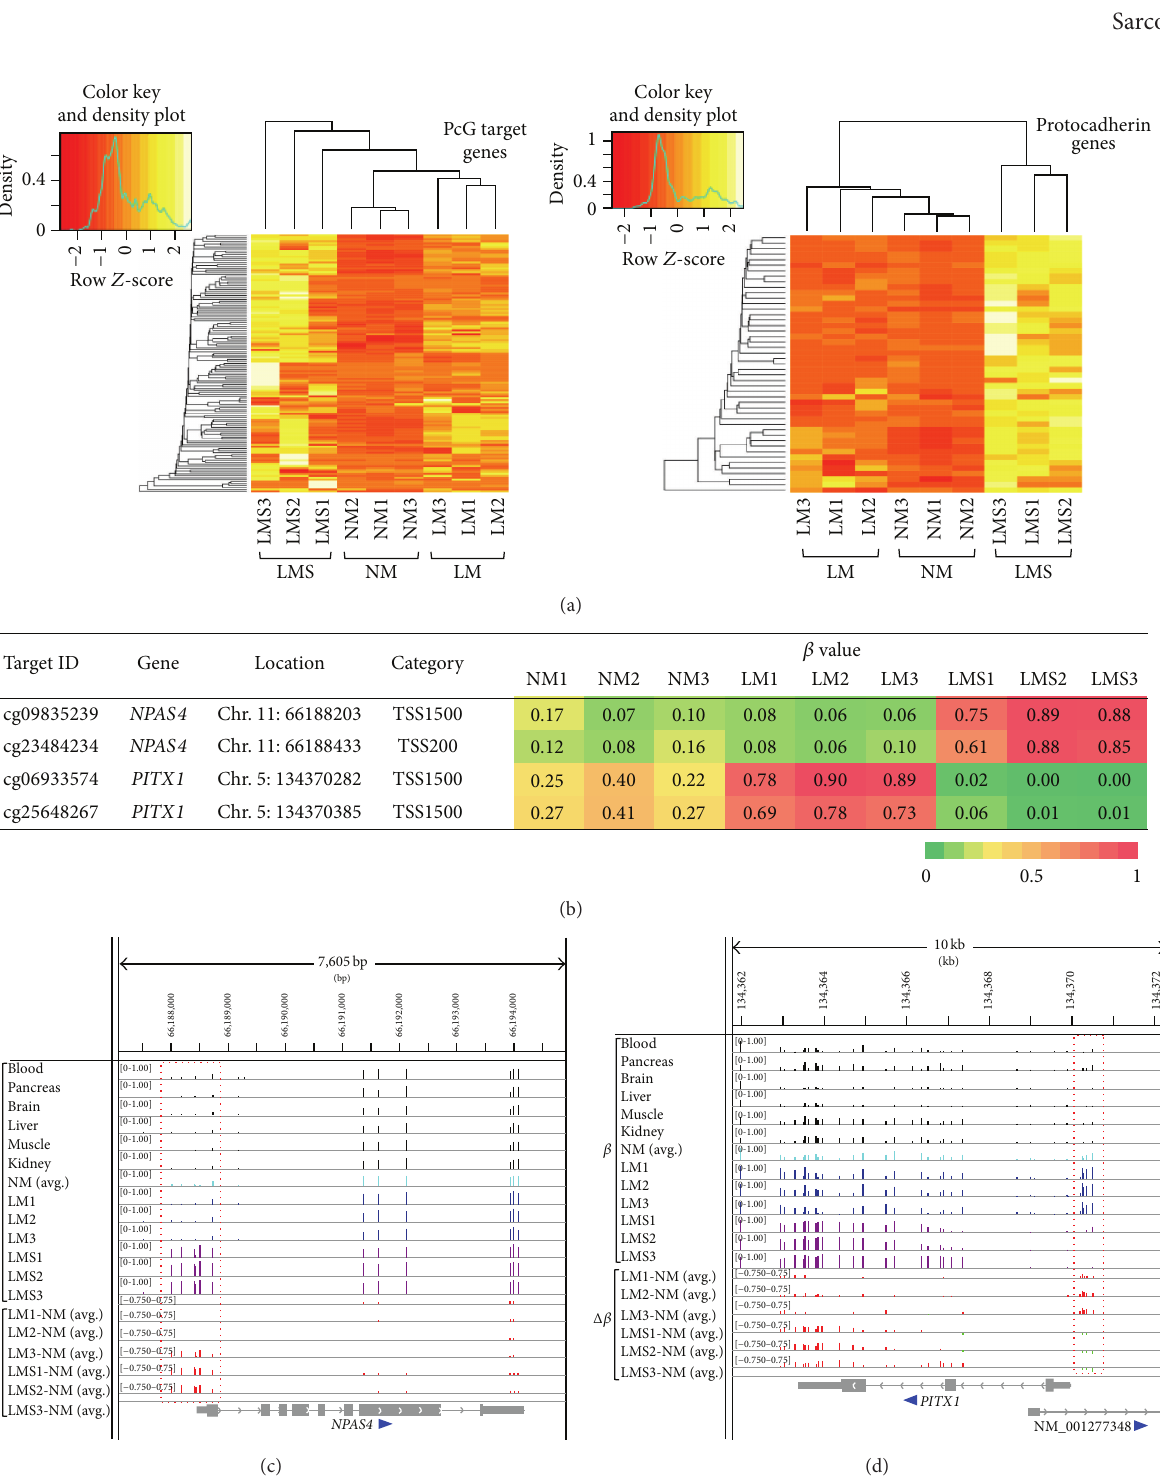
Figure 5: Candidate methylation markers to distinguish LM and LMS. (a) Clustering analyses of TSS200 probes at 37 PcG target gene loci (left) and 15 protocadherin gene loci (right) hypermethylated ( Δ𝛽 > 0.2) in LMS compared to NM. The standard deviations of 𝛽 values of 133 CpG probes (at 37 PcG target loci) ranged from 0.01 to 0.38 (median 0.22). The standard deviations of 𝛽 values of 47 CpG probes (at 15 protocadherin genes) ranged from 0.06 to 0.31 (median 0.22). 𝛽 values and 𝑍 -scores of those 133 and 47 CpG probes in NM, LM, and LMS samples are shown in Supplementary Material, Table S7. (b) Four selected promoter CpG sites whose methylation levels were strikingly different between LMS and LM. (c) and (d) DNA methylation profiles at NPAS4 and PITX1 loci. Methylation 𝛽 values (data range: 0 to 1) and Δ𝛽 values (data range: − 0.75 to 0.75) are shown as vertical bars using the Integrative Genomics Viewer. The colors of vertical bars for 𝛽 values are as follows: black for six normal tissues (blood, pancreas, brain, liver, muscle, and kidney), light blue for the average of three NM samples (“NM(avg.)”), blue for LM samples, and purple for LMS samples. Positive and negative Δ𝛽 values for each of the LM and LMS samples (compared to NM(avg.)) are indicated by red and green vertical bars, respectively. The promoter region containing the probes shown in (b) is boxed by red dashed lines. Exon-intron structure and transcriptional orientation of the gene(s) are shown at the